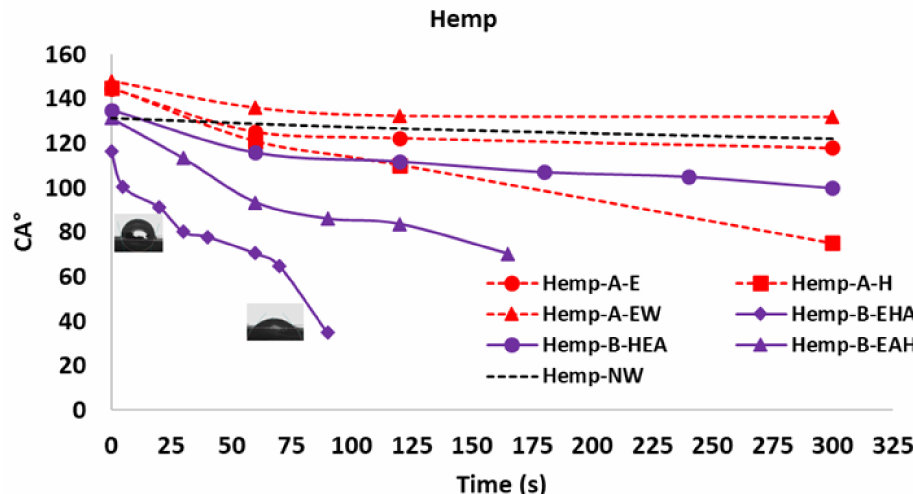
Figure 9. Results obtained for the SCA of hemp